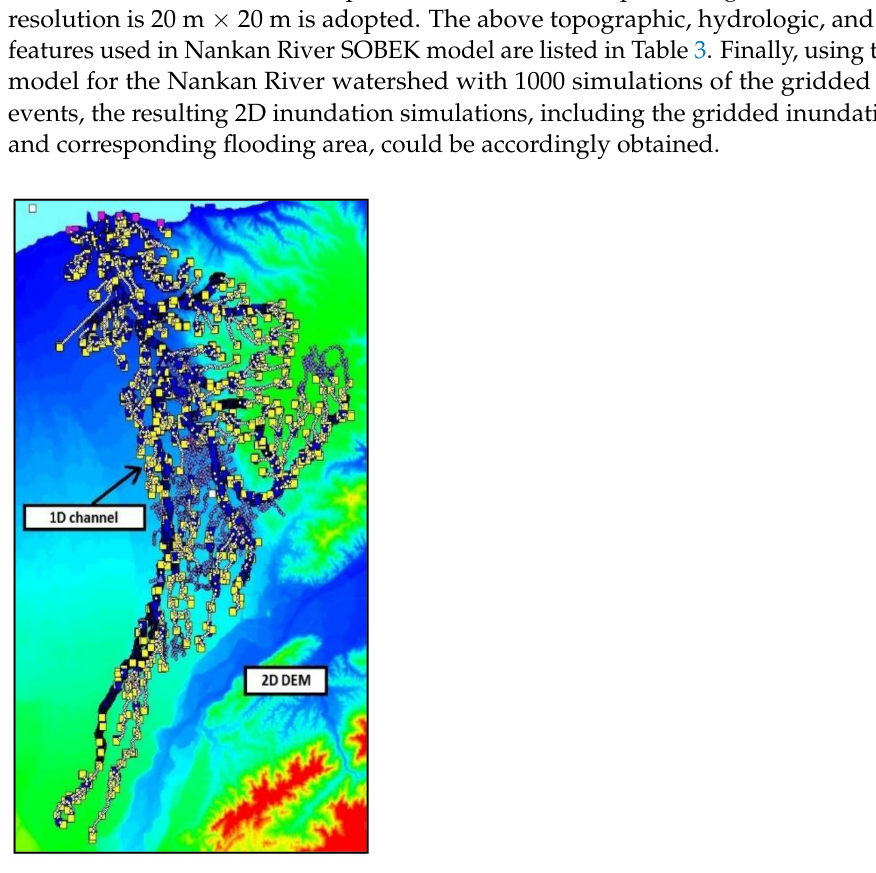
Figure 6. 2D SOBEK model for the study area (Nankan River watershed) (note: the circle is the rainfall-runoff computing node for each